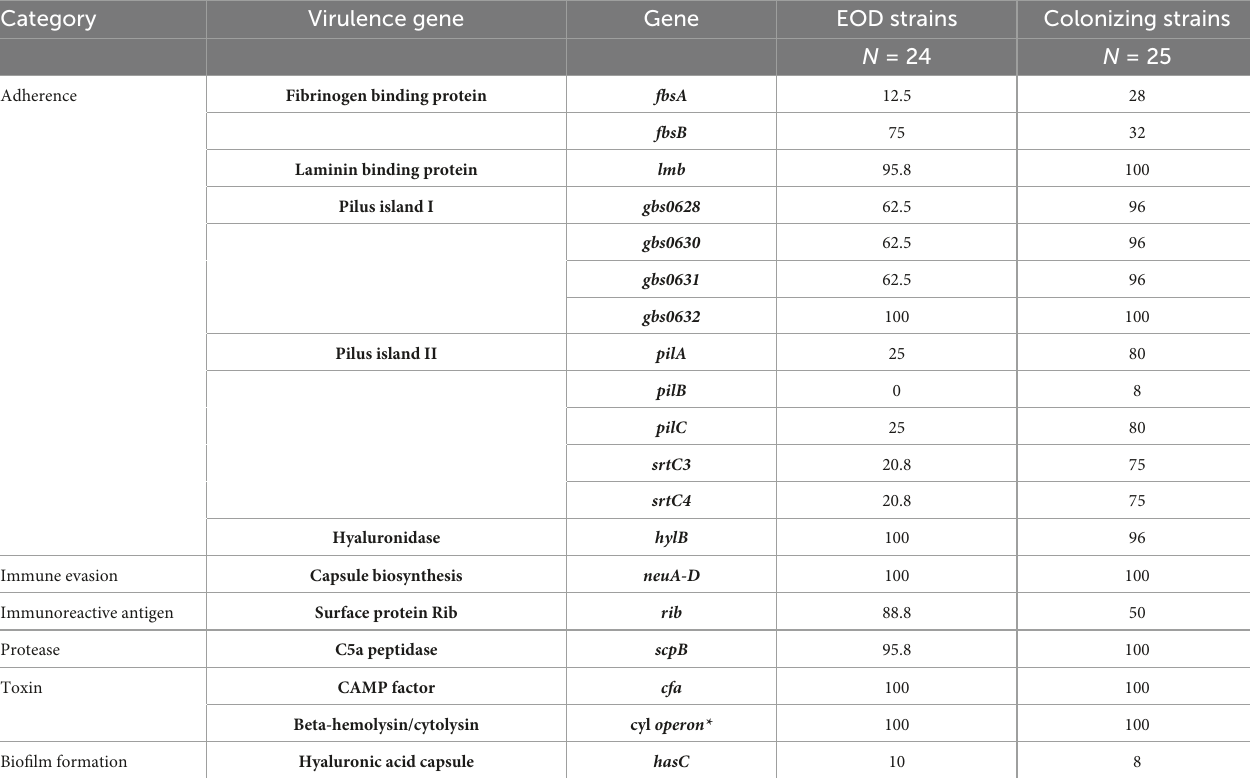
TABLE 6 Percent of isolates positive for virulence genes across 49 group B streptococcus (GBS) strains from Mayanei Hayeshua Medical Center (MHMC) (detected by PATRIC based on VGFD database). Category Virulence gene